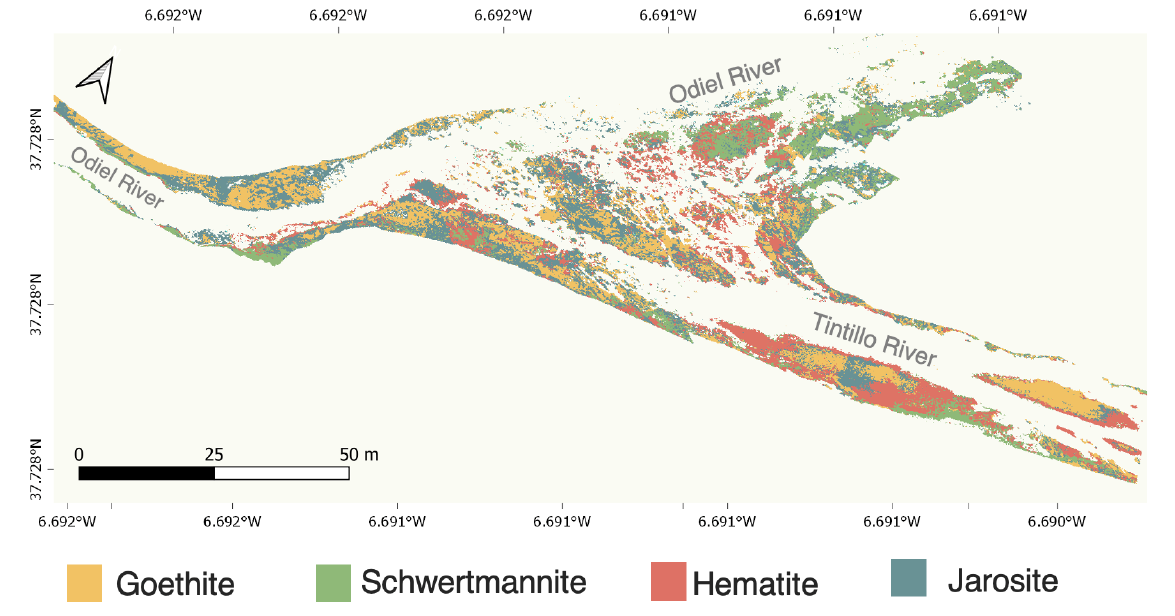
Figure 12. Spectral Angle Mapper (SAM) supervised classification for the four endmembers minerals in the Tintillo–Odiel